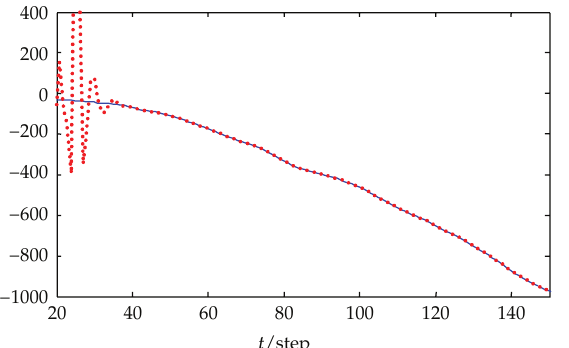
(cid:5) II (cid:6) s (cid:5) t | t (cid:6) 1